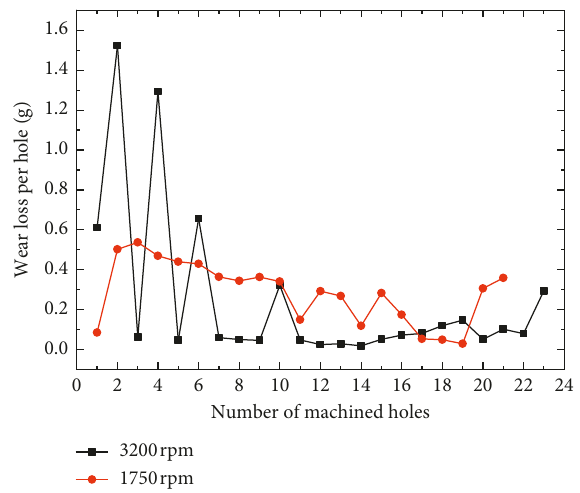
Figure 9: Wear rates of the bit under different spindle